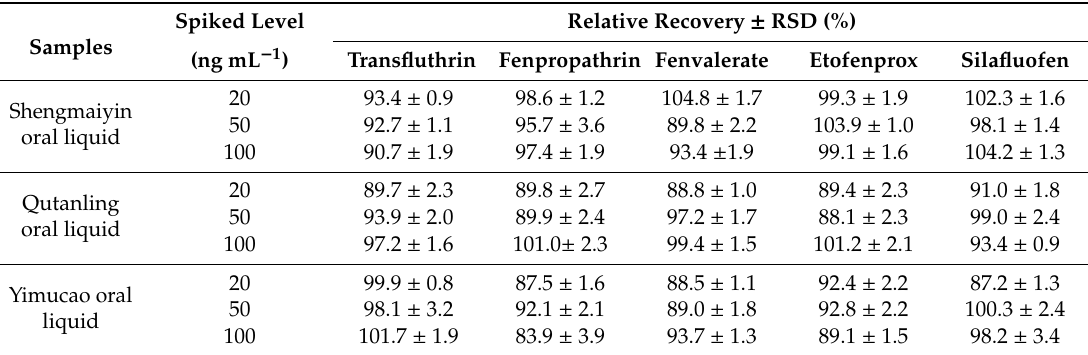
Table 2. Analysis of Traditional Chinese medicine (TCM) samples and spiked recoveries ( n = 3).